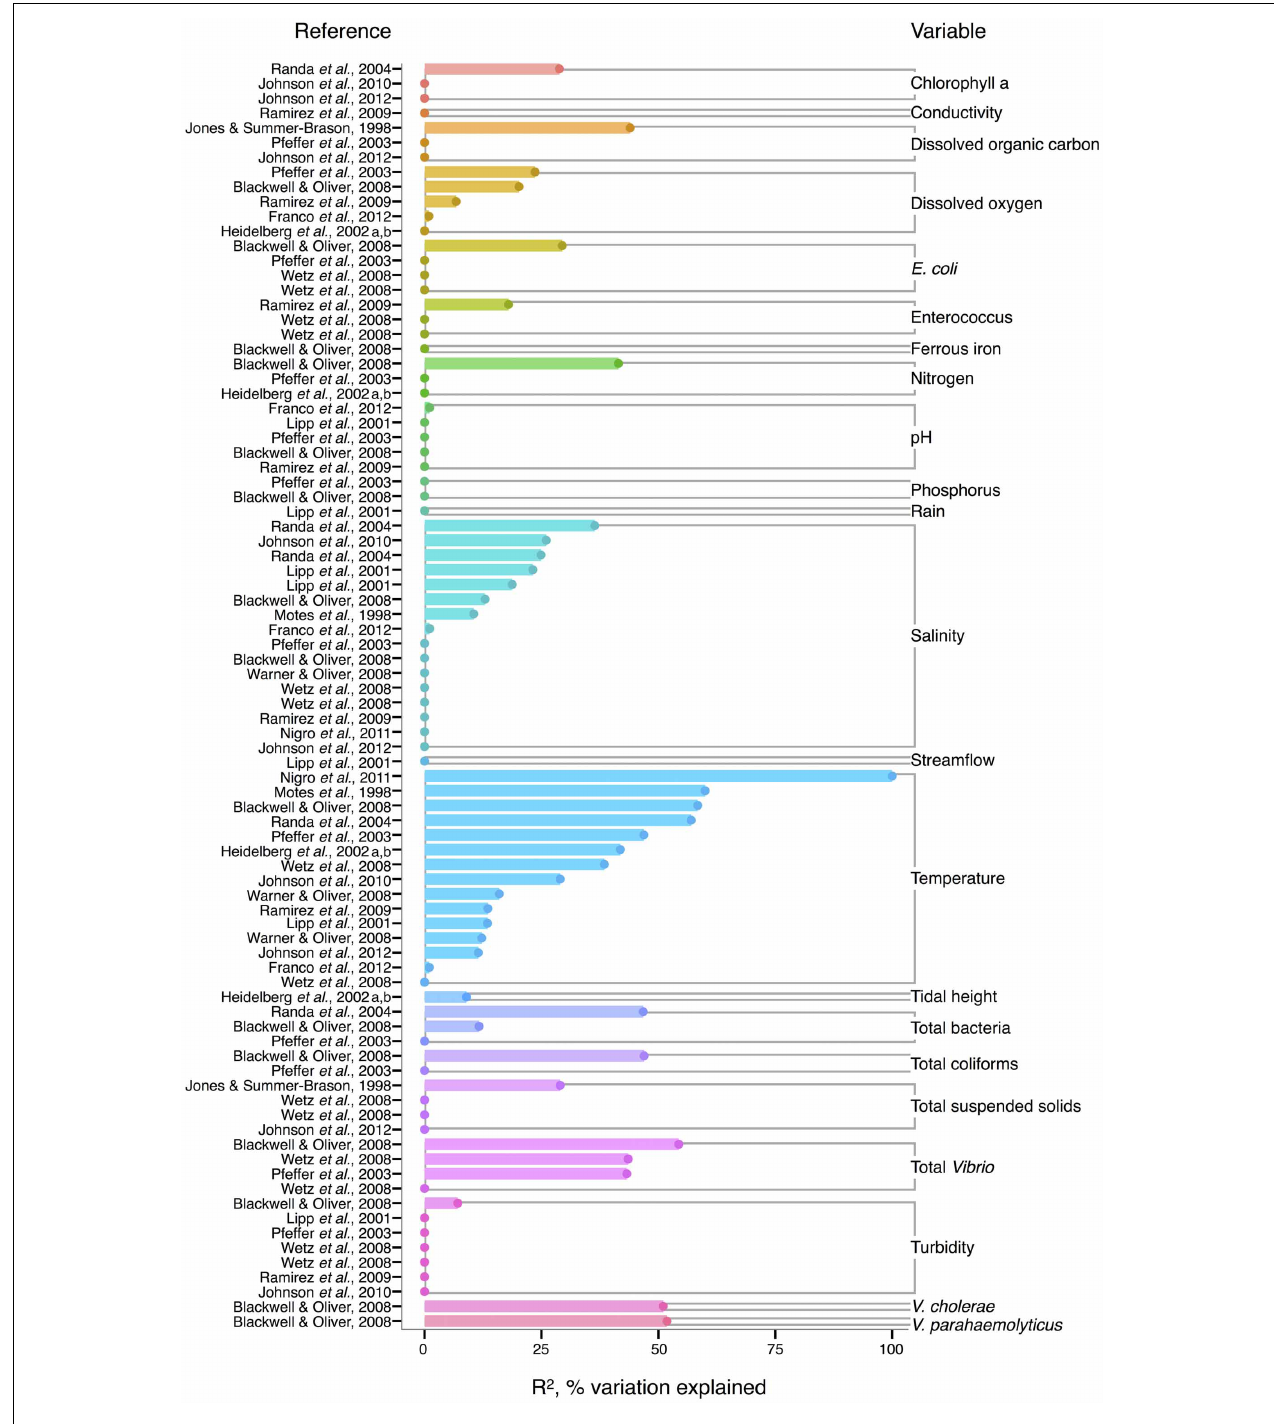
reference. A reference may conduct multiple analyses for a given variable (e.g., on subsets of data or considering different variables combinations for data regression). Dots indicate bar heights, and where a dot occurs without a bar, R 2 was non-significant (i.e., R 2 = 0).